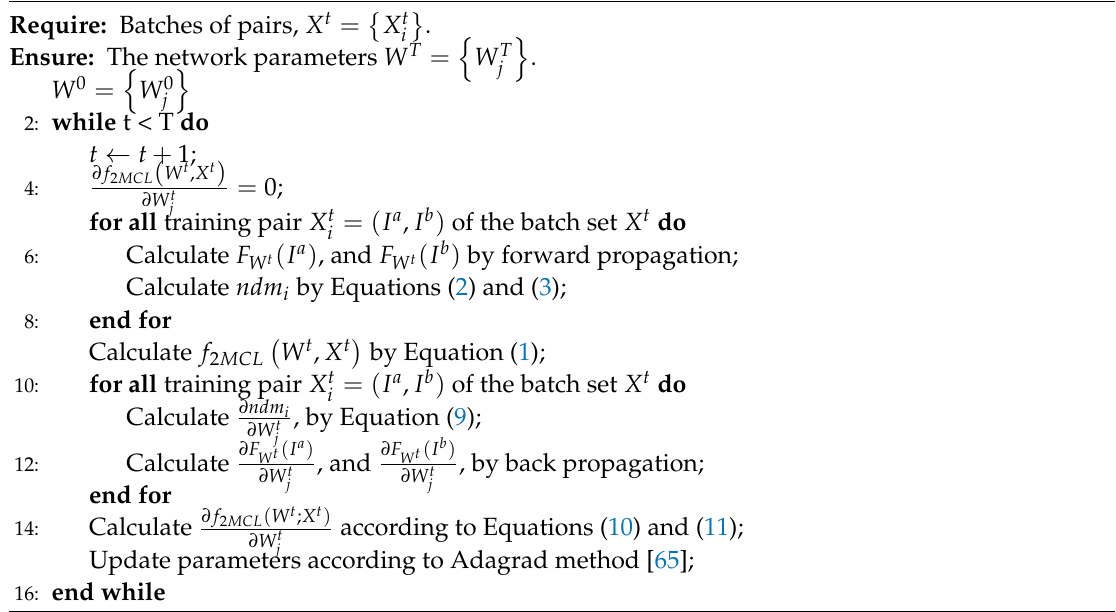
Algorithm 1 computes the features of each pair of images from the training batch by forward propagation, and the distance between them, ndm by Equations (2) and (3). Then, the value of the loss function f 2 MCL is obtained with Equation